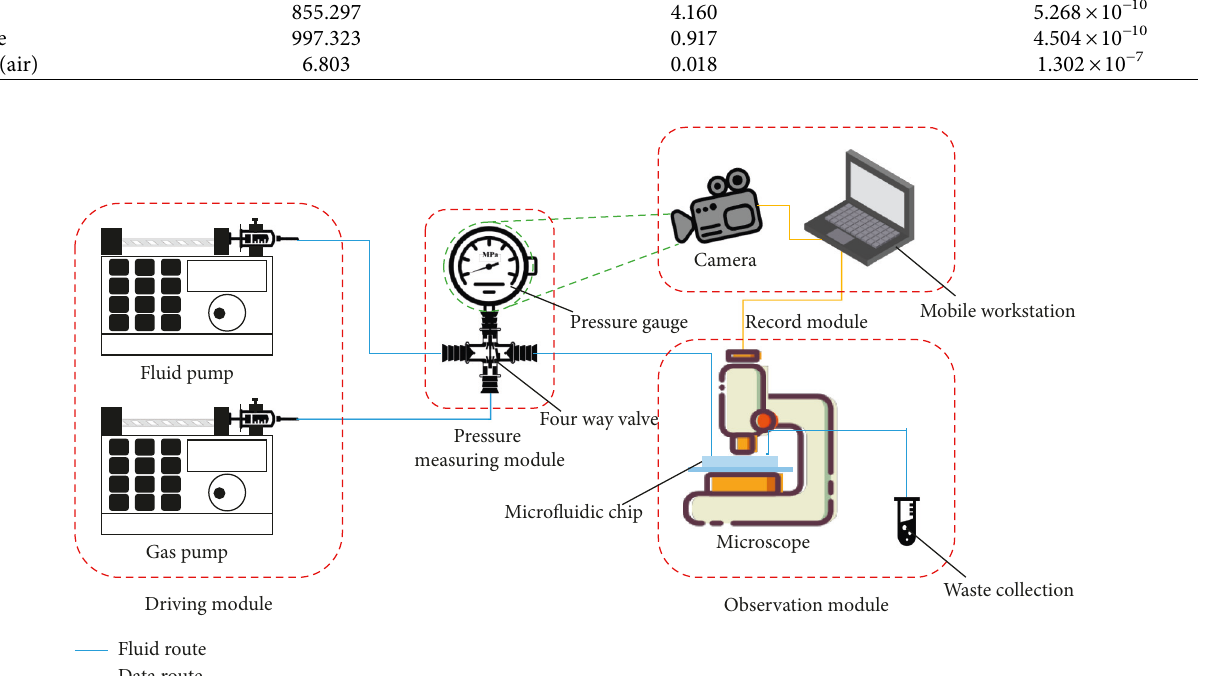
Figure 3: The schematic of microfluidic injection experiment and data record.